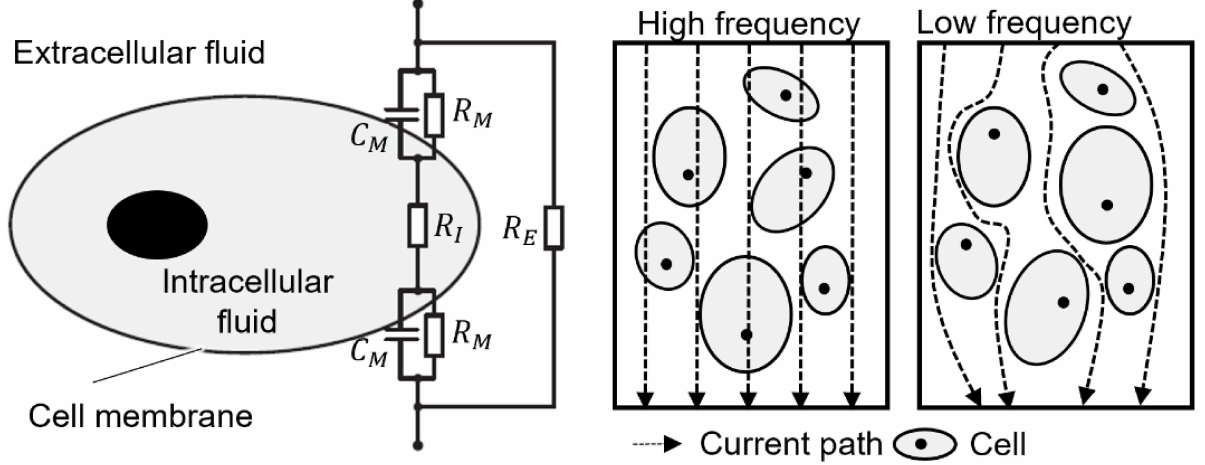
Figure 3. Electrical equivalent circuit of a cell ( left ) and current paths through cell suspensions ( right